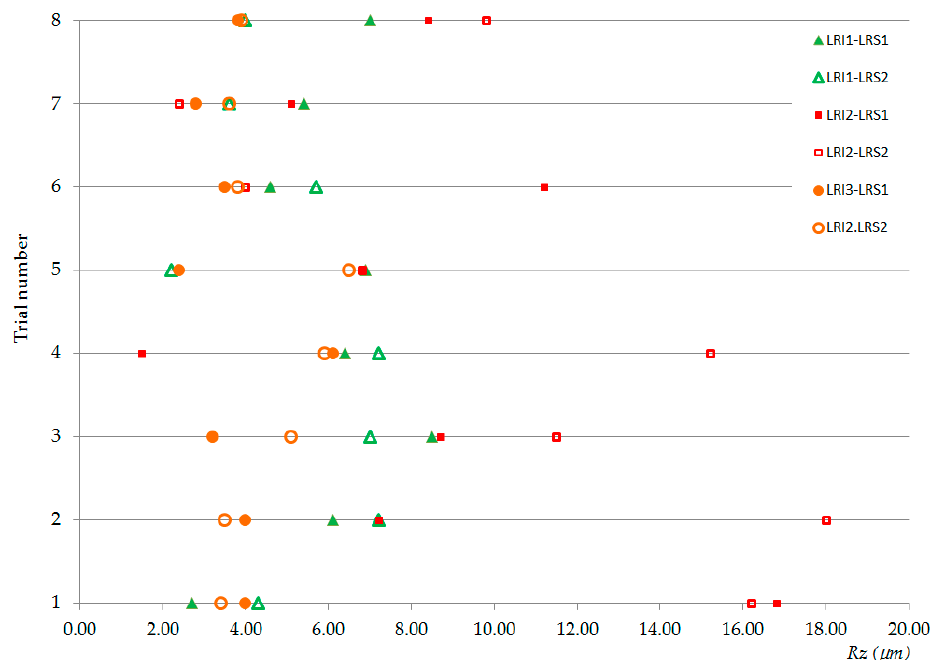
Figure 7. Graphic representation of the Rz values.